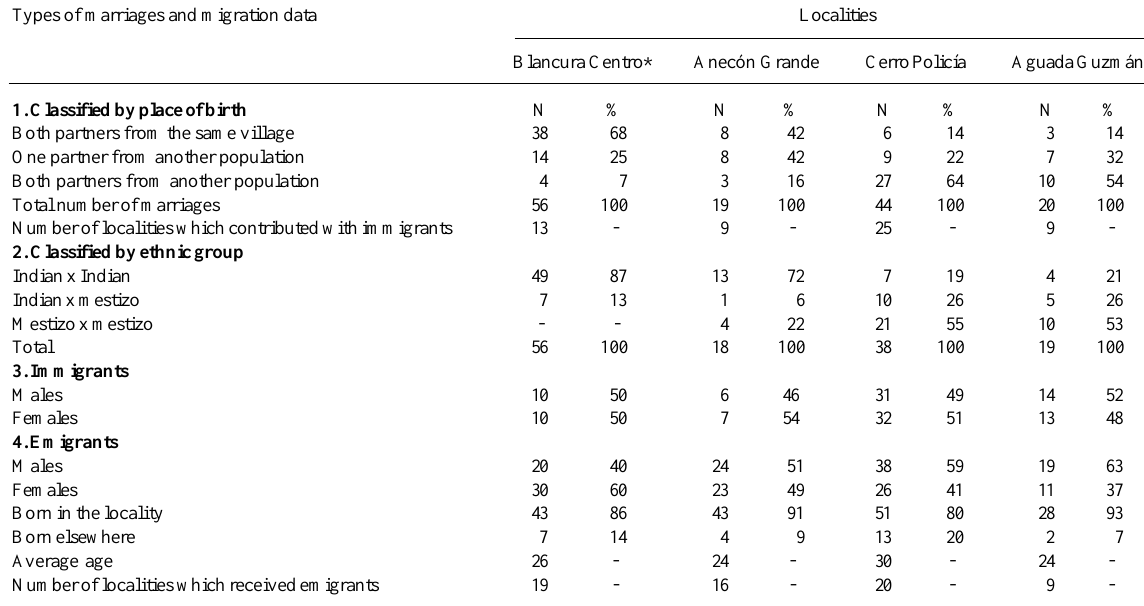
Table I - Types of marriages and migration data for the Argentinean Mapuche populations studied.